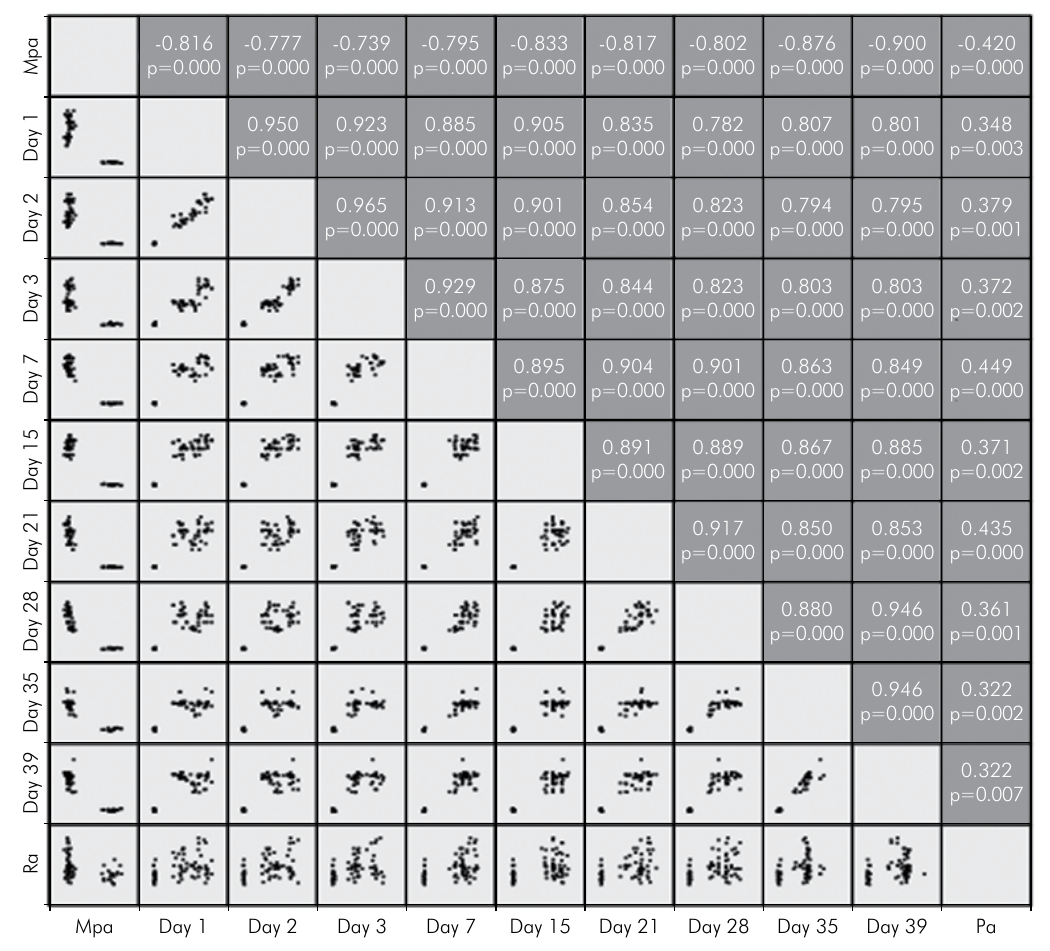
Figure 3. Pearson’s correlation coefficient values for the properties of the materials. A statistically significant positive correlation was observed between surface roughness (Ra) and fluoride release (p<0.05). The statistically significant negative correlation was found between surface roughness and flexural strength (MPa), and between fluoride release and flexural strength